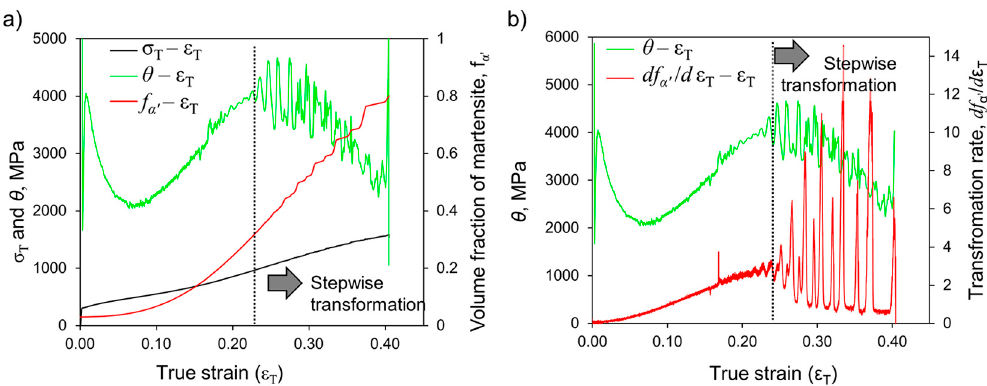
Figure 10. ( a ) Evolution of true stress ( σ T ), instantaneous work-hardening rate ( θ ) and f α (cid:48) with true strain ( ε T ). ( b ) Evolution of θ and martensite formation rate ( df highlights the origin of the stepwise transformation.